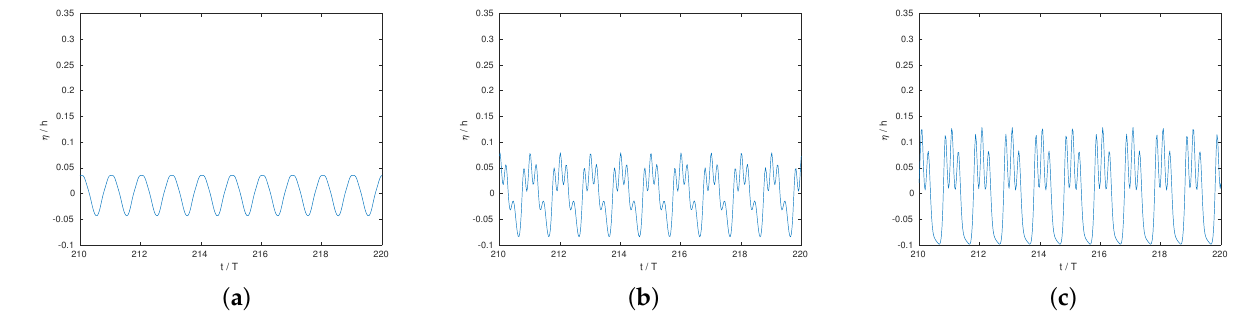
Figure 4. Dimensionless free surface elevations time histories of pure sway cases under different excitation frequencies: ( a ) ω / ω 1 = 0.92; ( b ) ω / ω 1 = 0.94; ( c ) ω / ω 1 = 0.96.